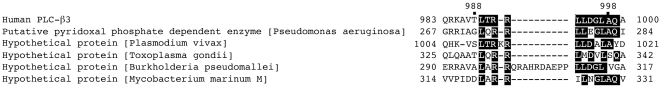
Homology between peptide b of PLC-β3 and hypothetic proteins of parasites and bacteria.BLAST Search was performed using peptide b as a query sequence. Identical residues are shown in a black background.